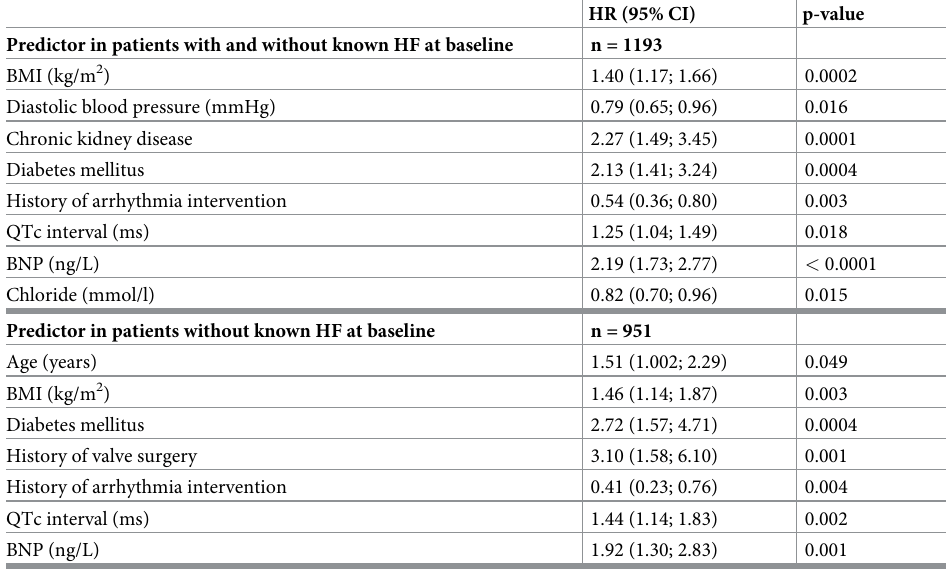
Table 2. Predictors of hospitalization for heart failure (HF) in patients with and without known HF at baseline. HR (95% CI) p-value Predictor in patients with and without known HF at baseline n = 1193 BMI (kg/m 2 ) 1.40 (1.17; 1.66) 0.0002 Diastolic blood pressure (mmHg) 0.79 (0.65; 0.96) 0.016 Chronic kidney disease 2.27 (1.49; 3.45) 0.0001 Diabetes mellitus 2.13 (1.41; 3.24) 0.0004 History of arrhythmia intervention 0.54 (0.36; 0.80) 0.003 QTc interval (ms) 1.25 (1.04; 1.49) 0.018 BNP (ng/L) 2.19 (1.73; 2.77) < 0.0001 Chloride (mmol/l) 0.82 (0.70; 0.96) 0.015 Predictor in patients without known HF at baseline n = 951 Age (years) 1.51 (1.002; 2.29) 0.049 BMI (kg/m 2 ) 1.46 (1.14; 1.87) 0.003 Diabetes mellitus 2.72 (1.57; 4.71) 0.0004 History of valve surgery 3.10 (1.58; 6.10) 0.001 History of arrhythmia intervention 0.41 (0.23; 0.76) 0.004 QTc interval (ms) 1.44 (1.14; 1.83) 0.002 BNP (ng/L) 1.92 (1.30; 2.83) 0.001 Data are Hazard Ratios (HR) and 95% confidence intervals (95%CI). HR for continuous variables are per one standard deviation increase. BMI = body mass index; BNP = brain natriuretic peptide; history of arrhythmia intervention = previous pulmonary vein ablation or/and electrical cardioversion. BNP was